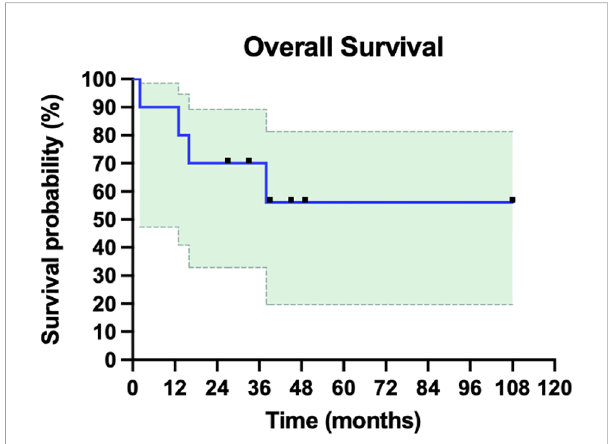
FIGURE 2 Overall survival of ten patients with metastatic or in-transit melanoma treated with iIL2 and BCG. Survival for each patient is measured as months alive since beginning intralesional therapy, to last follow-up or death. Shaded green is 95% con fi dence intervals. Mean overall survival was 43 months, and median overall survival in this cohort was 35.5